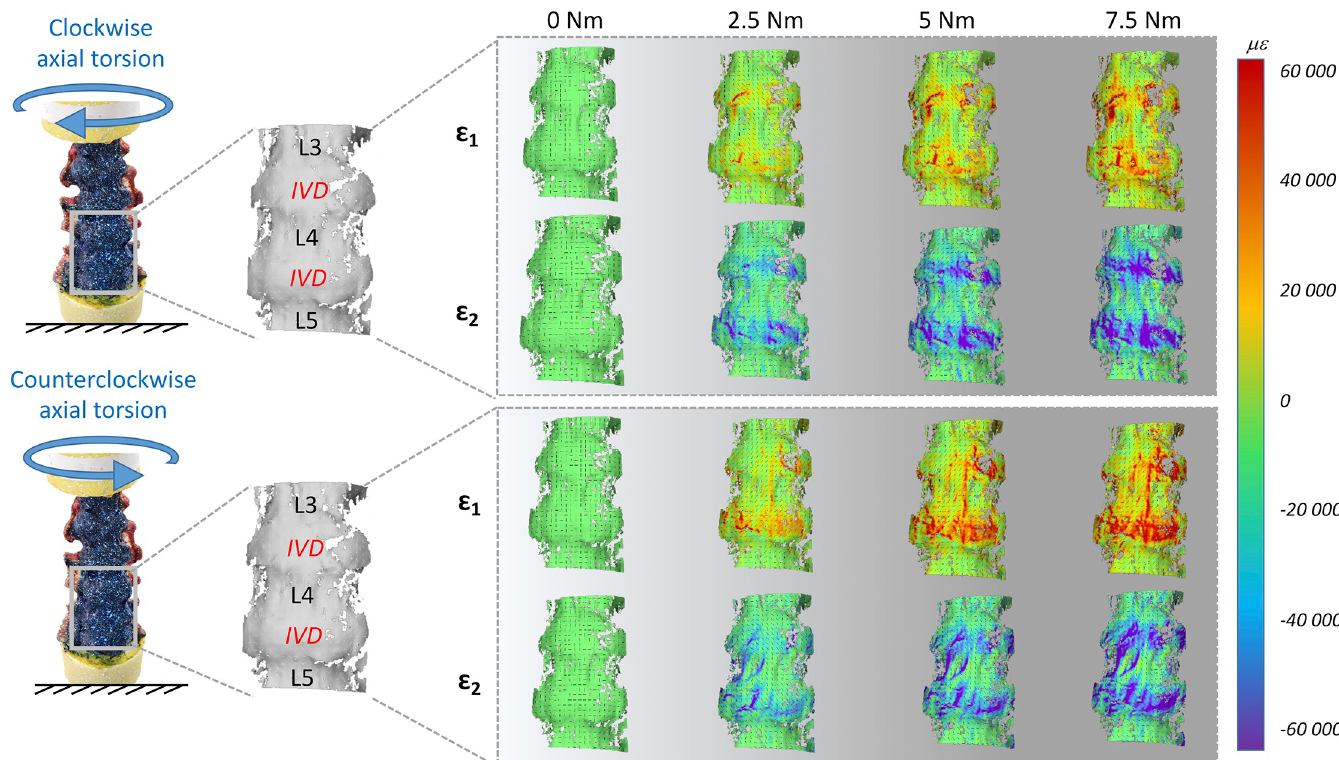
Fig 6. Axial Torsion: Maximum (eps 1 ) and minimum (eps 2 ) principal strain fields during the progression of the loading cycle (0.0, 2.5, 5.0, 7.5 Nm) in both opposite directions. The images on the left show the actual specimen under load and the correlated (the vertebrae and IVDs are labelled). The false-colours maps show the non-uniform distribution of strain. The black dashes indicate the principal strain directions. A typical specimen (#2) is shown here. Similar patterns were observed in all 5 specimens (the strain maps for all the individual specimens are reported in the S1 Fig, S1 and S2 Dataset). A movie of the entire loading cycle is available